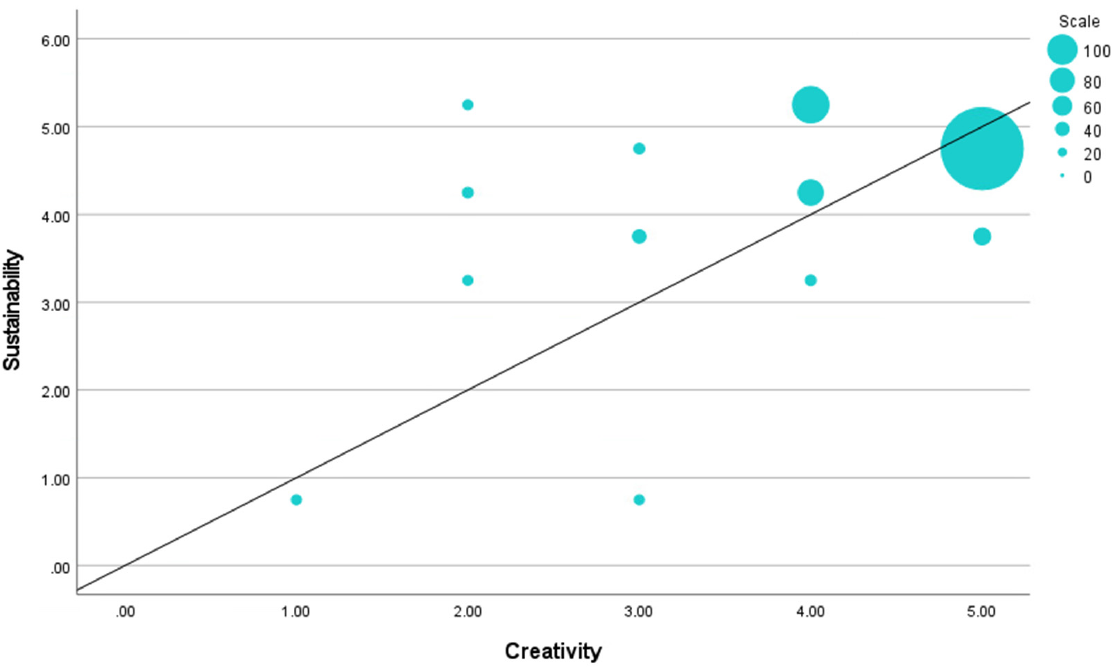
Figure 6. Relationship between Sustainability and Creativity.